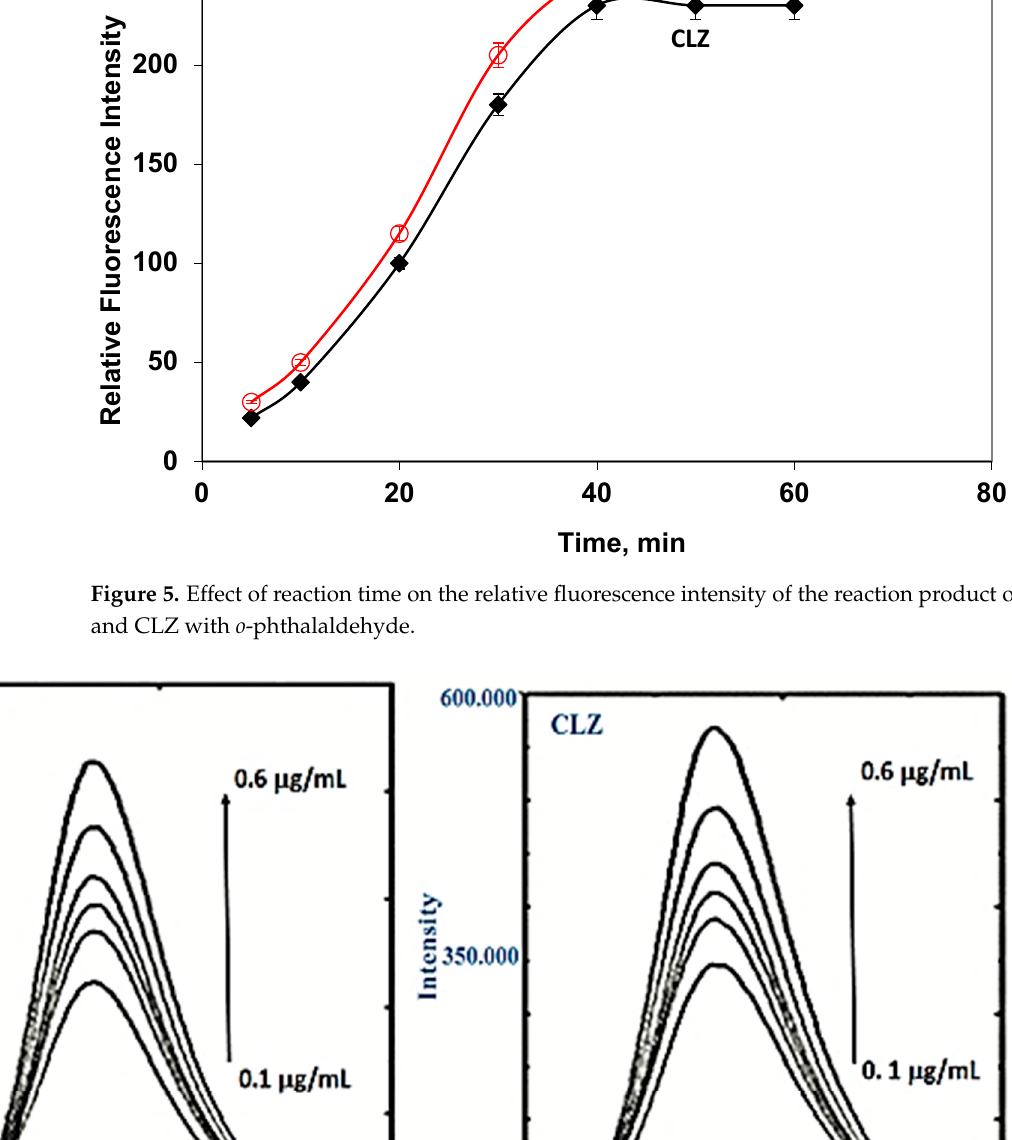
Table 1. Analytical parameters for spectrofluorometric assessment of aripiprazole and clozapine.